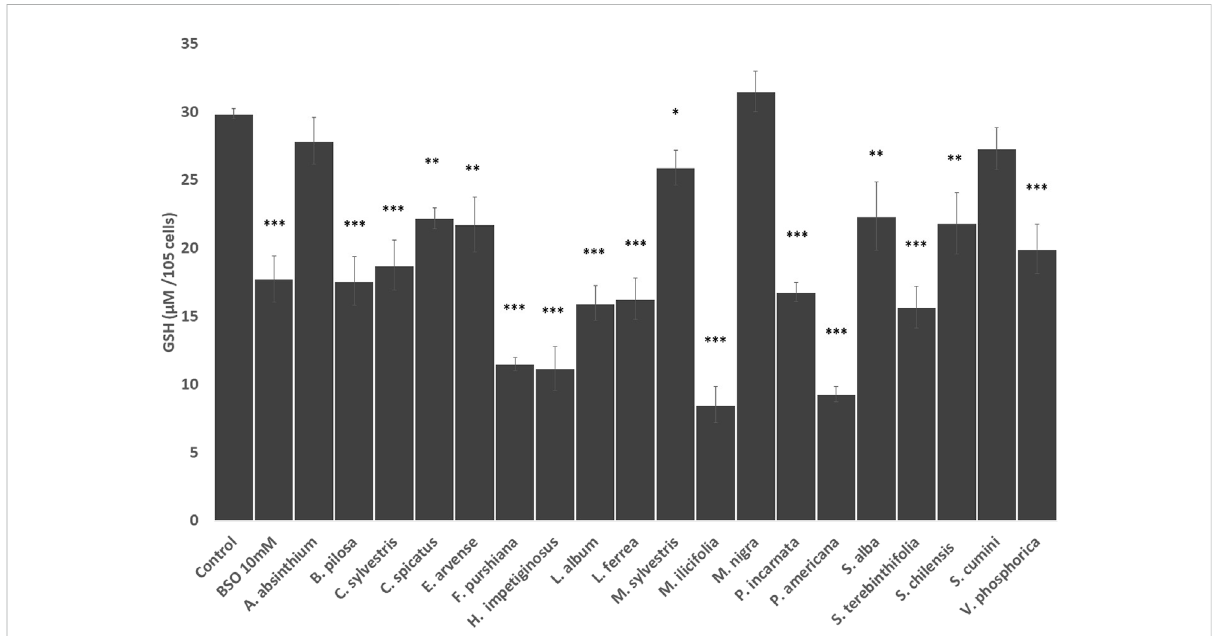
FIGURE 2 Effects of the selected herbal preparations (100 mg/ml) and buthioninesulphoximine (BSO, 10 mM, positive reference treatment) on the levels ofintracellularglutathioneinHEPG2cells(Mean±SEM, n ≥ 3).Statisticalsigni fi canceagainstwater(control)accordingtoBonferroni(* p < 0.05,** p < 0.01, *** p < 0.001).